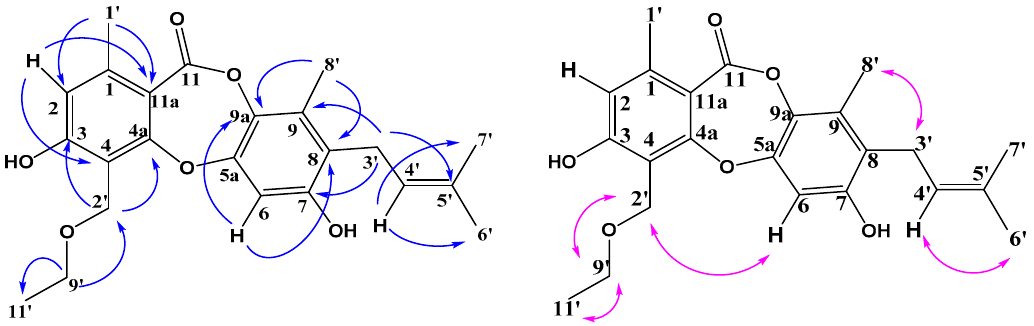
Figure 2. Key HMBC (H-C) correlations and NOESY (H-H) correlations of mollicellin O ( 1 ).